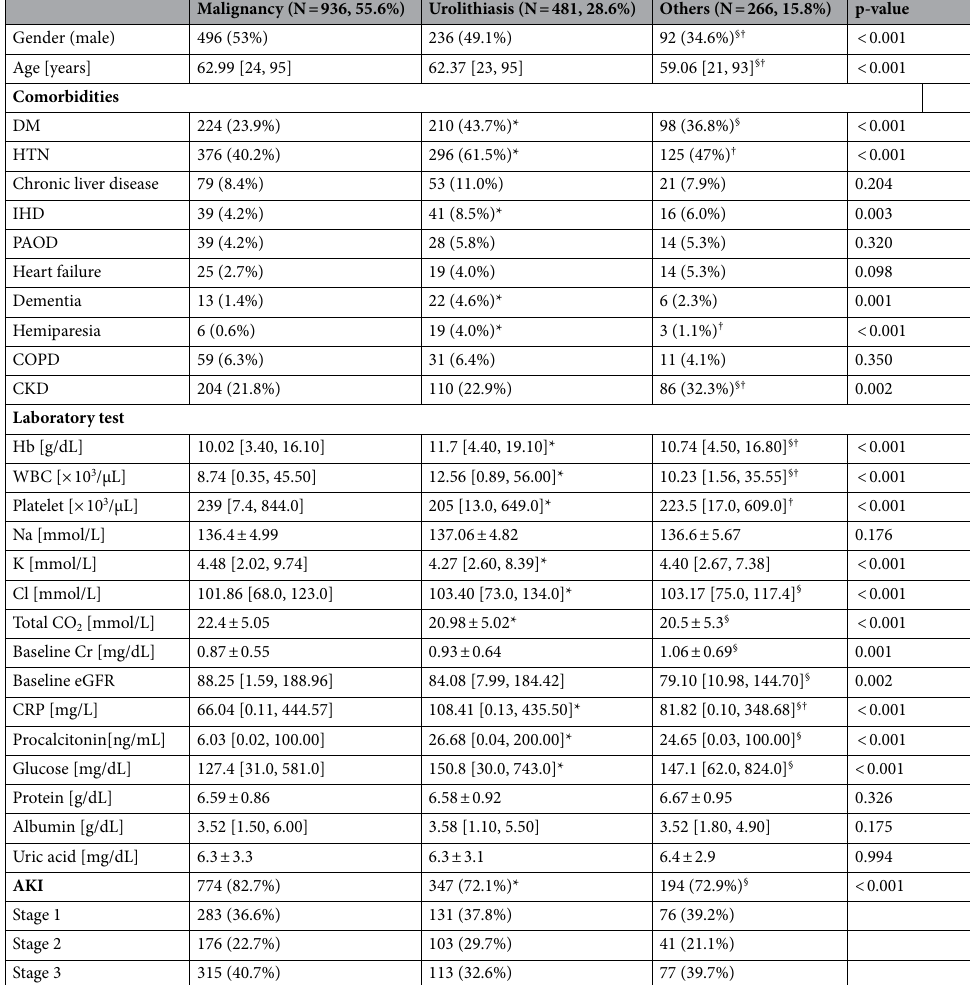
Table 1. Demographic and clinical characteristics of the study cohort according to etiologies. DM diabetes mellitus, HTN hypertension, IHD ischemic heart disease, PAOD peripheral arterial occlusive disease, COPD chronic obstructive pulmonary disease, CKD chronic kidney disease, Hb hemoglobin, eGFR estimated glomerular filtration rate, CRP C-reactive protein, AKI acute kidney injury. *Malignancy vs. urolithiasis, § malignancy vs. others, † urolithiasis vs. others, p-value <